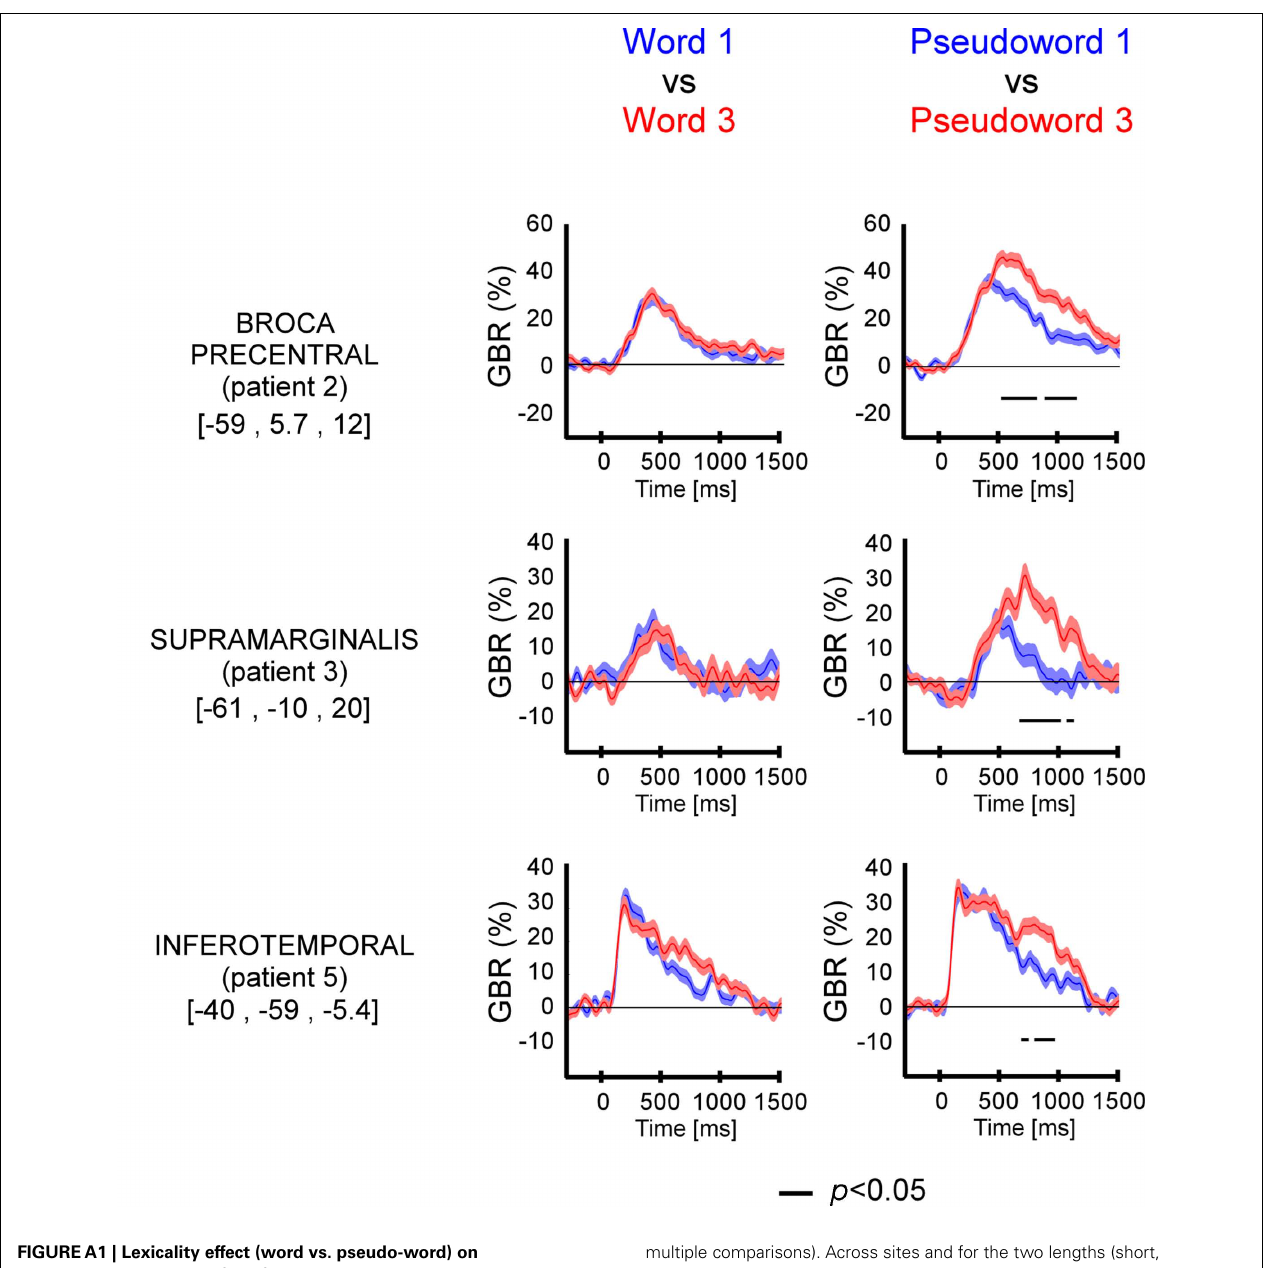
FIGUREA1 | Lexicality effect (word vs. pseudo-word) on gamma-band responses (GBR) recorded in ITOC, Broca’s, and SMG in patients P2, P3, and P5. The black line underneath the curves indicates time samples when the two conditions were significantly different ( p < 0.05, Kruskal–Wallis, FDR corrected for